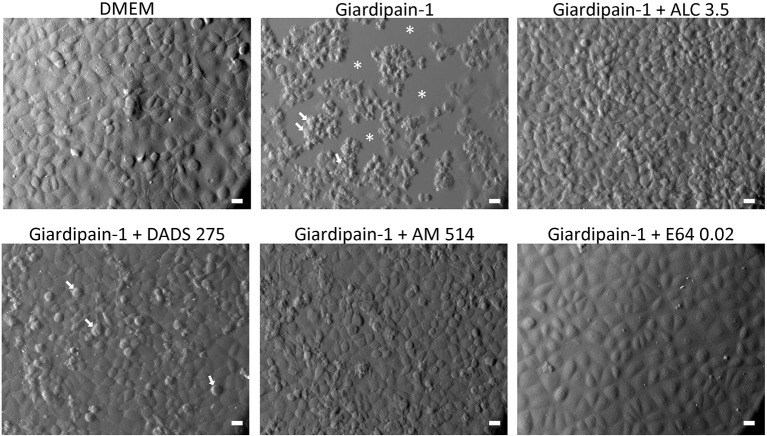
Effect of garlic TACs on the cytolytic damage caused by giardipain-1 in epithelial IEC6 cell monolayers. Confluent IEC6 cells were exposed for 100 min at 37°C to affinity chromatography-purified giardipain-1 alone or pre-incubated with the concentrations indicated (in mM) of representative TACs that caused inhibition of its protease activity in zymograms and monolayers were observed by Nomarski optics. Asterisks denote zones of monolayer destruction and arrows point to cells undergoing apoptotic death as indicated by membrane blebbing, shrinkage, and shape degeneration. Bars: 20 μm.